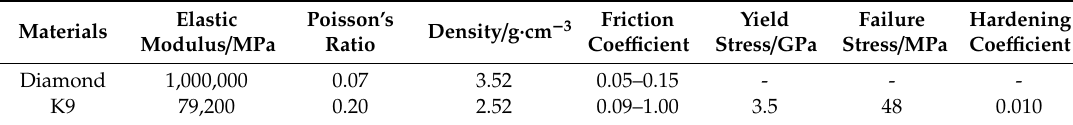
Table 1. Main parameters of the